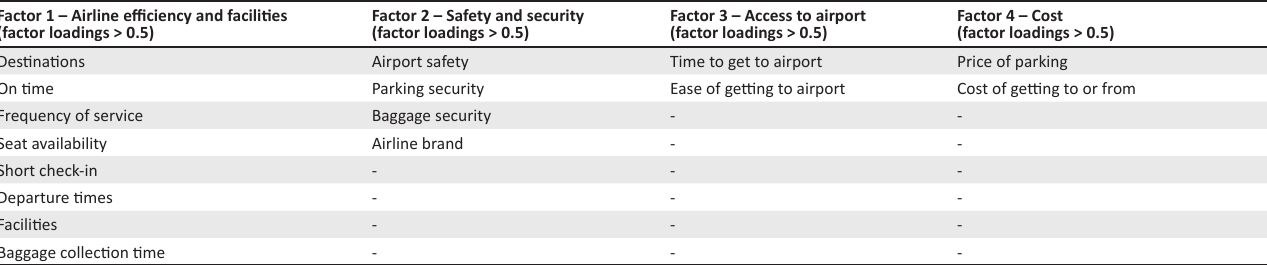
TABLE 6: Latent factor structure of attributes (2013). Factor 1 – Airline efficiency and facilities (factor loadings > 0.5)